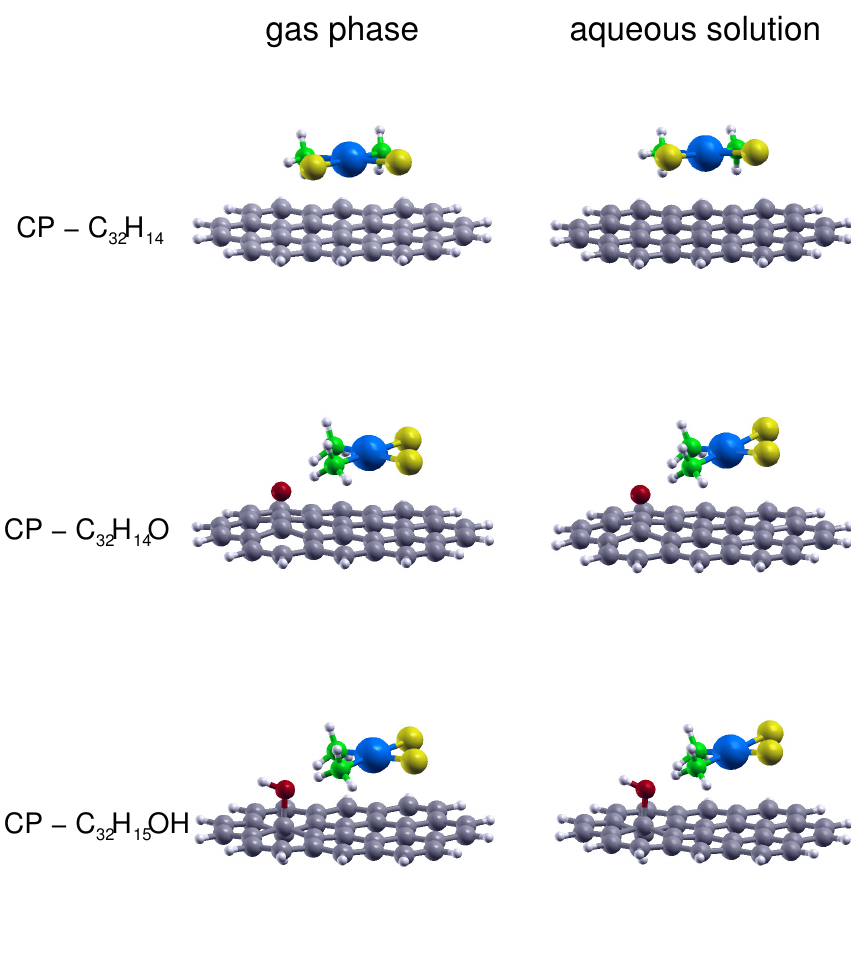
Figure 3. Side views of the CP–C 32 H 14 , CP–C 32 H 14 O and CP–C 32 H 15 OH gas phase optimized structures together with those obtained in aqueous solution by considering the SMD continuum solvation